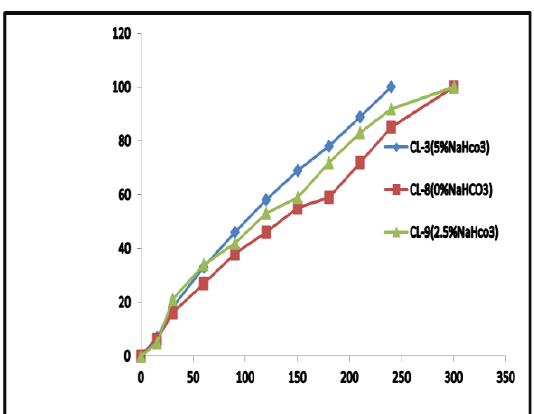
Figure5:The effect of sodium bicarbonate amount on the release of clopidogrel in 0.1N HCl and 37˚C.